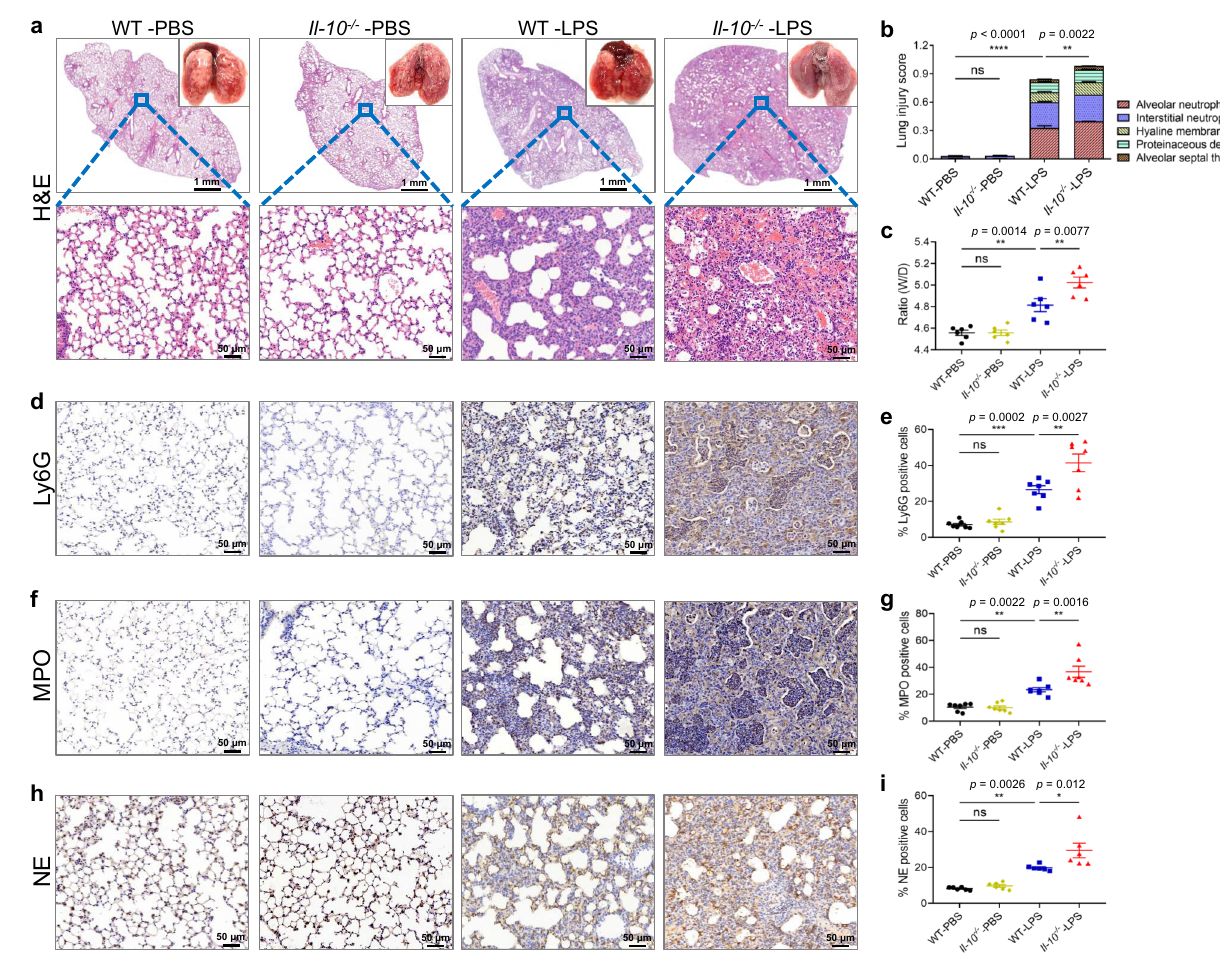
Fig. 2 | IL-10 de fi ciency exacerbates the extensive lung injury induced by LPS. a Representative images of lungs and H&E-stained tissue sections at 24h after LPS stimulation. Scale bars in the upper panel, 1mm; scale bars in the below panel, 50 µ m. b Lung damage was determined by 5 pathophysiological features to obtain the total injury score, n =6 in each group. c The permeability of alveolocapillary membrane was evaluated by the lung wet/dry (W/D) ratio, n =6 in each group. d – i Immunohistochemical staining and quantitative analysis of Ly6G ( d , e , n =7 in